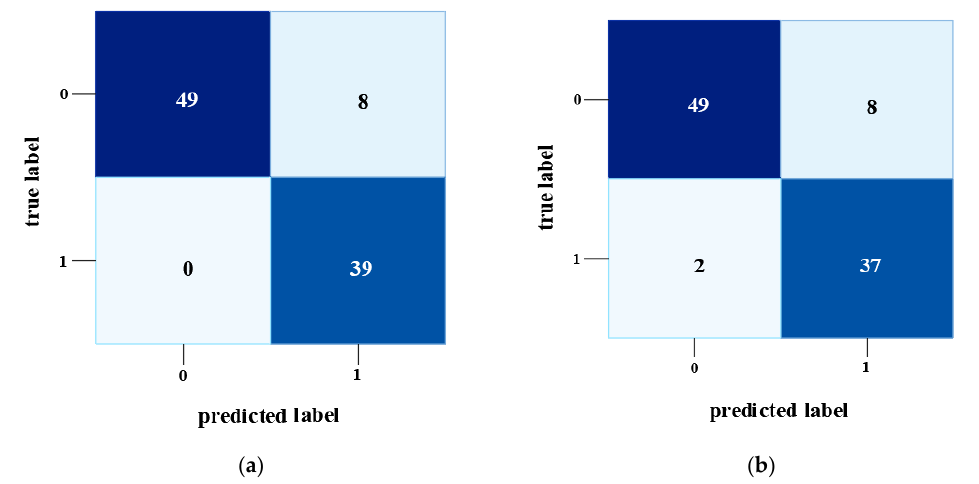
Figure 5. Defects classification: comparison of the evaluation metrics based on SGD and RMSprop optimization function for learning rate 0.001. Figure 6. Confusion matrix for InceptionV3 and Xception for optimizer SGD and learning rate 0.001. ( a ) InceptionV3 (SGD). ( b ) Xception (SGD).